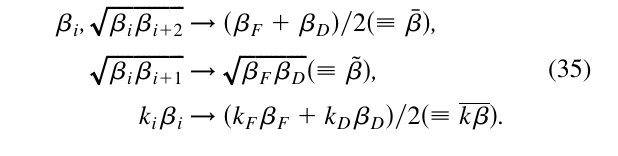
TABLE I. List of assumptions and approximations for analytic formula. Energy deviation, (cid:1)E , is constant for each particle Same mean square of offset error for all BPM, following a normal distribution Uniform FODO lattice Large number of components, for taking averages Same energy gain in all